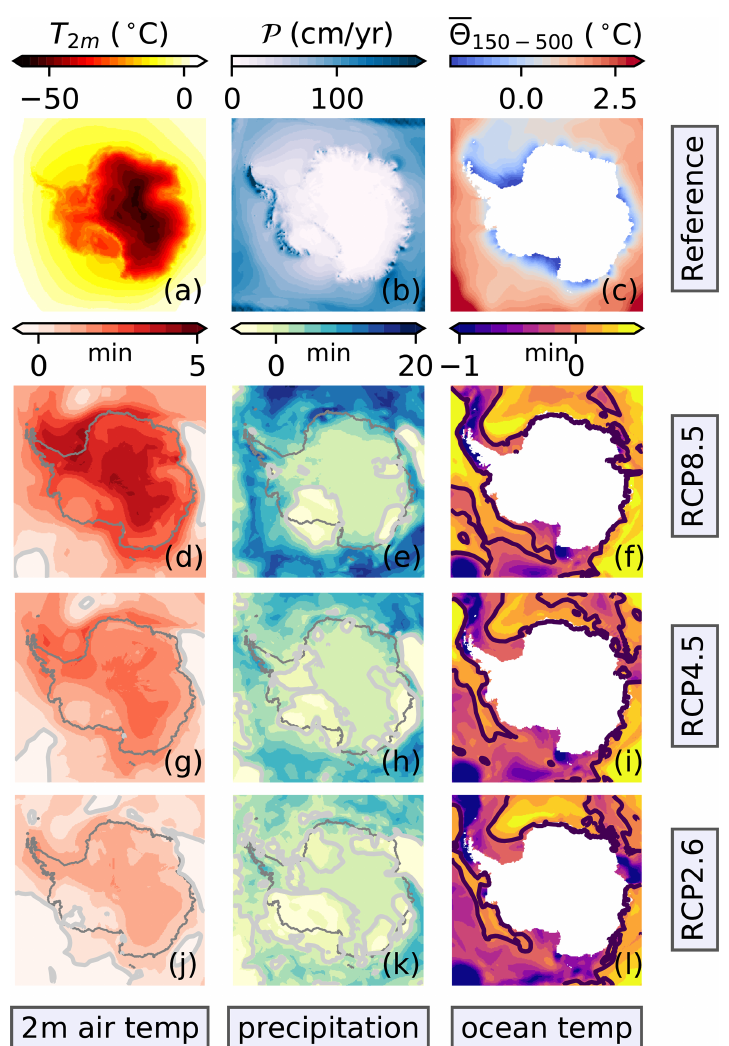
Figure E2. CMIP5 data set minimum anomalies (d–l) relative to the atmospheric (a, b) and oceanographic (c) reference forcing. The corresponding mean and maximum fields are depicted in Figs. 2 and E1, respectively. Panels (a–c) represent the reference fields to spin-up the ice sheet model (Table 2). The 2m air temperature (a) and the total precipitation (b) are mean fields from the regional RACMO model, and the ocean temperatures are from the World Ocean Atlas 2009 (c) . Below each reference field, the related minimum anomalies are compiled for the period from 2071 to 2100. Here, panels (d–f) , (g–i) , and (j–l) show the anomalies for RCP8.5, RCP4.5, and RCP2.6, respectively. The dark-gray line follows the current coastline. All potential ocean temperatures (c, f, i, l) are vertical means of the depth interval from 150 to 500m. The light-gray lines in the anomaly plots highlight the 2m air temperature threshold (d, g, j) of 0 ◦ C, the total precipitation threshold (e, h, k) of 0cmyr − 1 , and the potential ocean temperature threshold (f, i, l) of 0 ◦ C. All of these anomalies are the CMIP5 data set minimum of the models listed in Table 1; CCSM4 is not part of